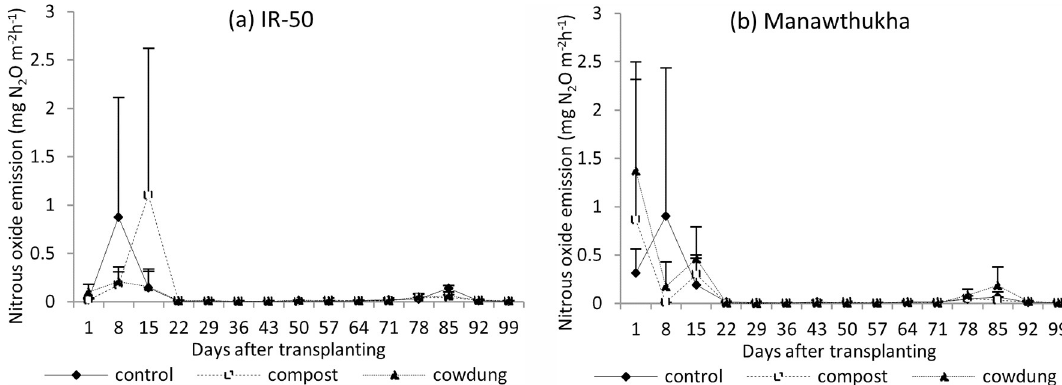
Fig 4. Nitrous oxide emission of rice varieties at Yezin Agricultural University during the wet season, 2016. Mean value ± standard deviation (n =